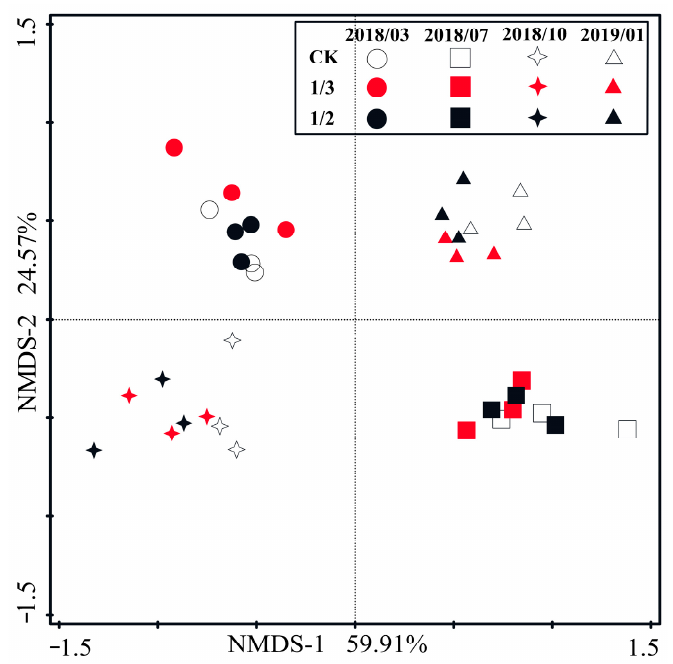
Figure 6. Nonmetric multidimensional scaling analysis (NMDS) of soil properties and enzyme